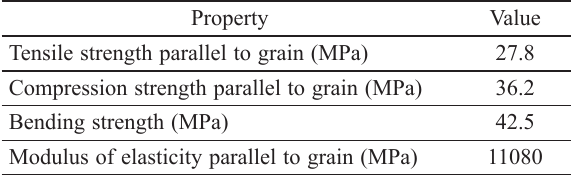
Table 1. Experimental mechanical properties of Spruce timber